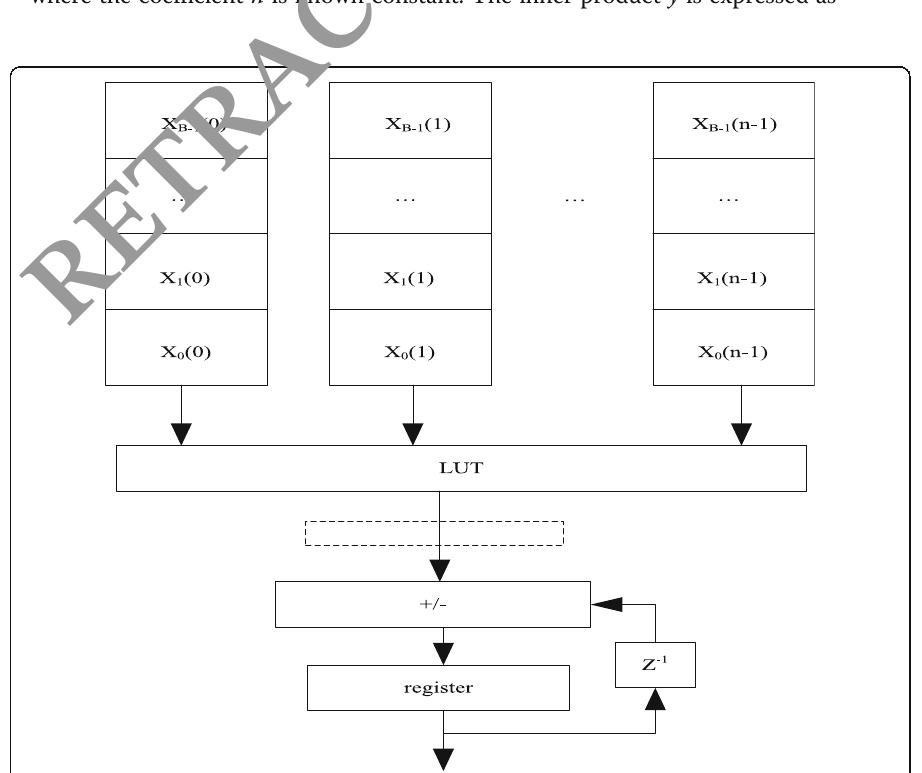
Fig. 2 Structure diagram of distributed algorithm for FIR